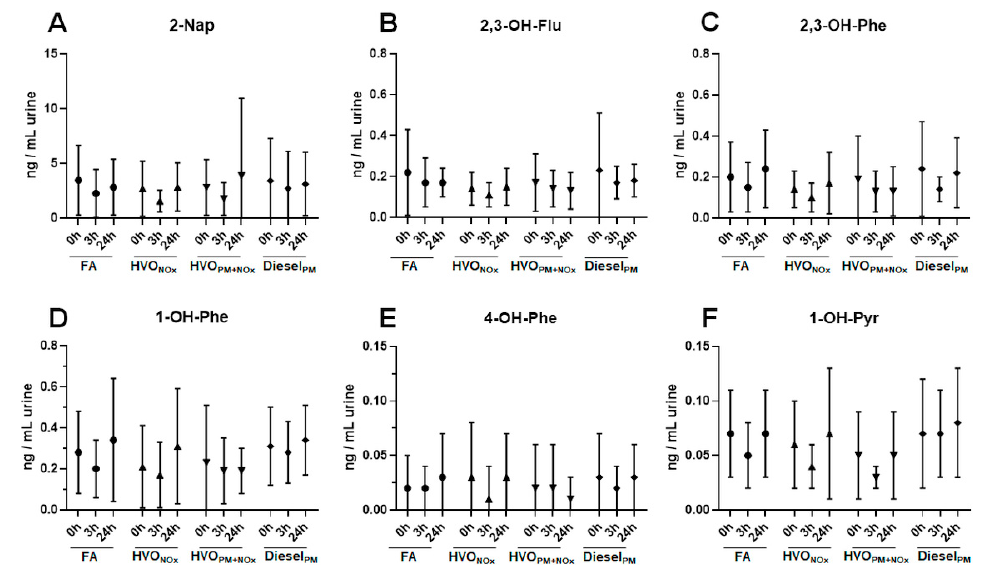
Figure 1. Urinary metabolites of PAHs after different exposure scenarios. Average and standard deviation of the urinary metabolites 2-Nap ( A ), 2,3-OH-Flu ( B ), 2,3-OH-Phe ( C ), 1-OH-Phe ( D ), 4-OH-Phe ( E ), and 1-OH-Pyr ( F ) from 18 volunteers after exposure to: filtered air (FA), HVO exhaust from a modern non-road vehicle with exhaust aftertreatment (HVO NOx ) and without exhaust aftertreatment (HVO PM+NOx ), as well as petroleum diesel exhaust (Diesel PM ). Statistical analysis was performed using Wilcoxon signed rank test. No significant difference ( p < 0.05) was observed between any of the exposure scenarios, including FA and the particle control (Salt PM ). All data are presented in Table S3.